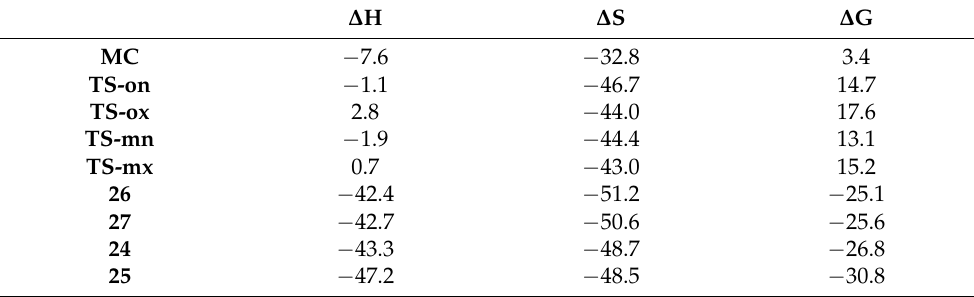
Table 2. ω B97X-D/6-311G(d,p) relative enthalpies ( ∆ H, kcal · mol − 1 ), entropies ( ∆ S, cal · mol − 1 · K − 1 ) and Gibbs free energies ( ∆ G, kcal · mol − 1 ) of the stationary points, computed at 65 ◦ C in methanol, involved in the 32CA reaction of AY 22 with phenyl vinyl sulphone 20 .